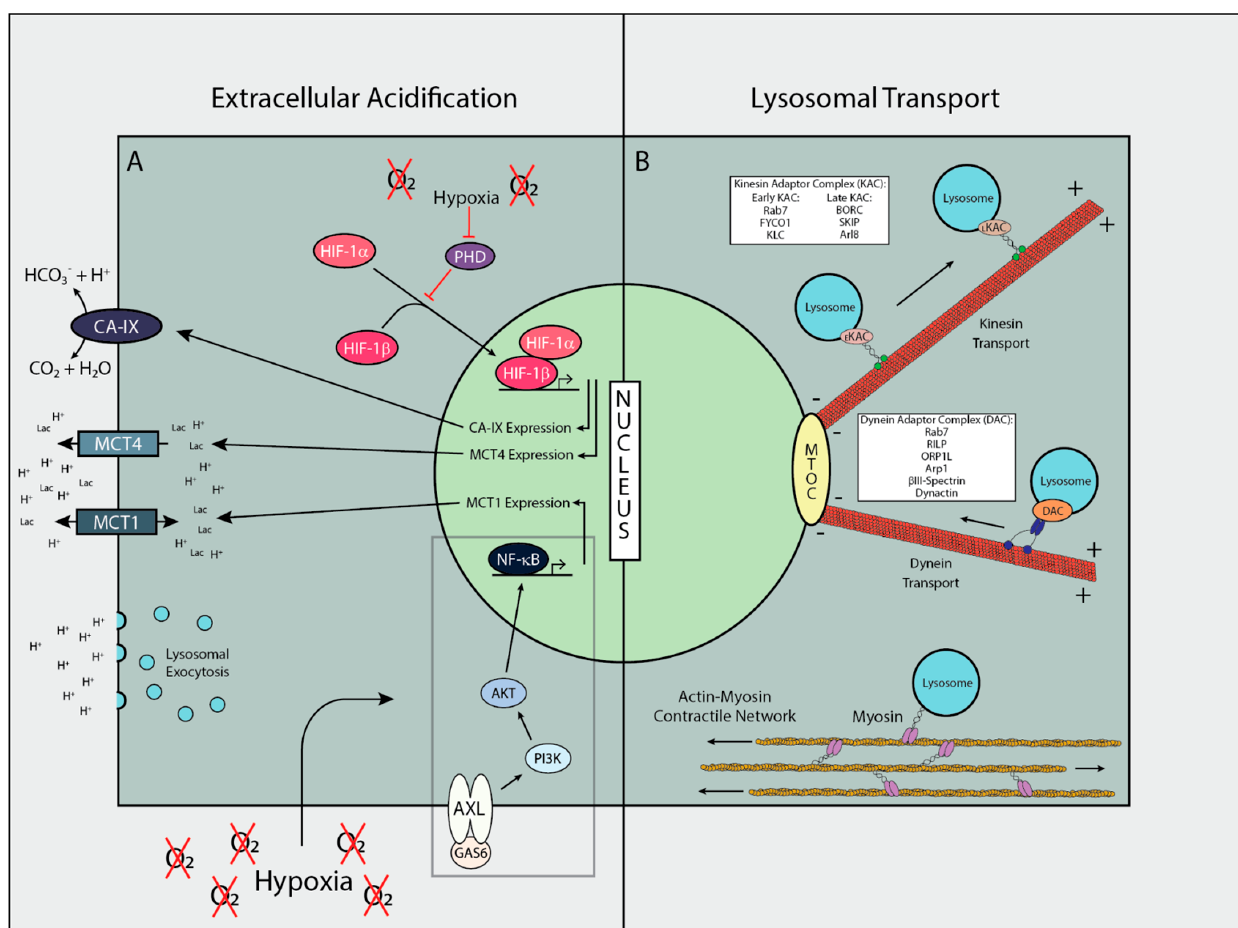
Figure 1. Mechanisms of Extracellular Acidification and Lysosomal Transport. ( A ) Extracellular milieu can be acidified by acid protrudes and pumps such as MCTs and CAs. Expression of these proteins that is influenced by external stimuli such as hypoxia changes the cells phenotype adapted to new microenvironment. ( B ) Main routes of lysosomal transport within the cell, and the proteins associated with each process. Dark grey—Cell body, Orange—Microtubules, Yellow—Actin Filaments, Light blue—Lysosomes. MTOC, Microtubule Organizing Center.